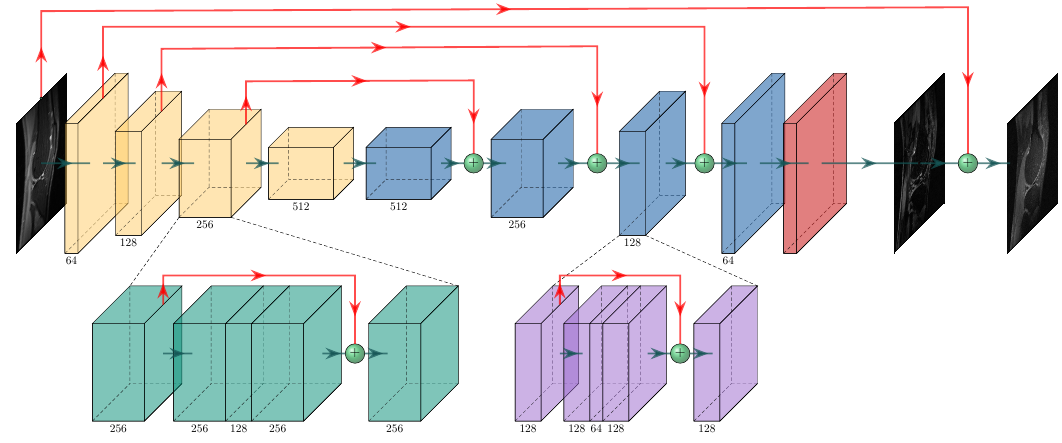
Figure 2. The generator G consists of four encoder blocks followed by corresponding 4 decoder blocks. In addition, shortcut connections are applied to connect mirrored layers between the encoder and decoder